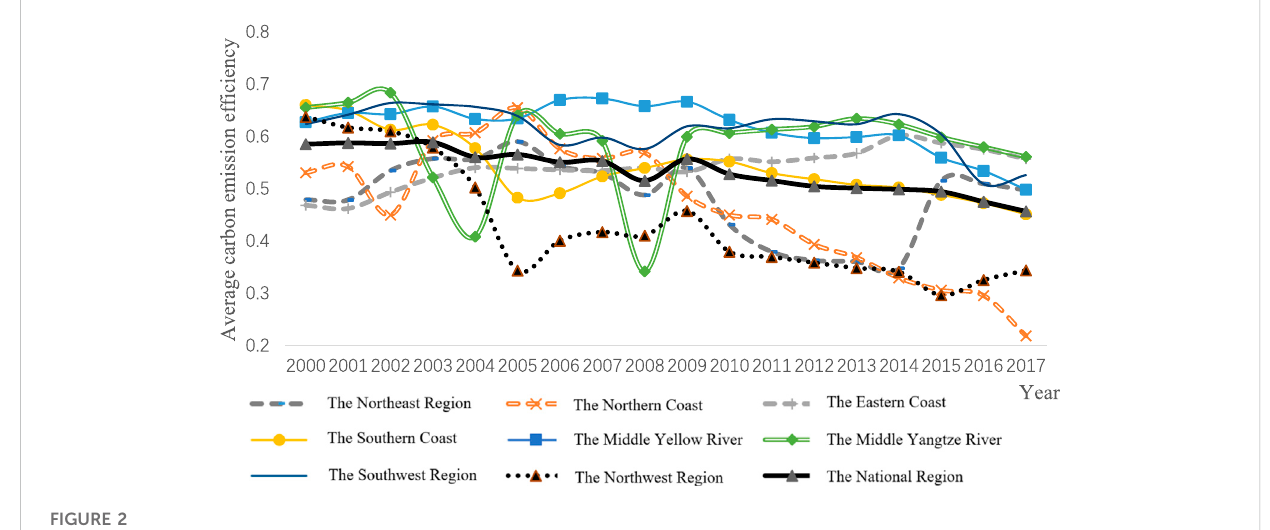
FIGURE 2 2000 – 2017 China ’ s eight regions and the national carbon emission ef fi ciency mean change